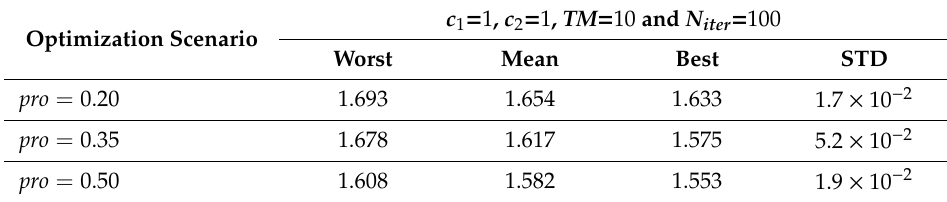
Table 10. Comparison under di ff erent values of pro : IAE